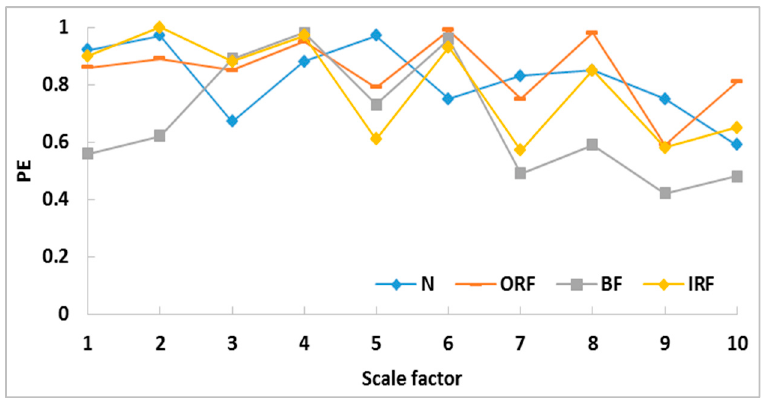
Figure 12. MPE of intrinsic mode function 1 (IMF1) for four health conditions.